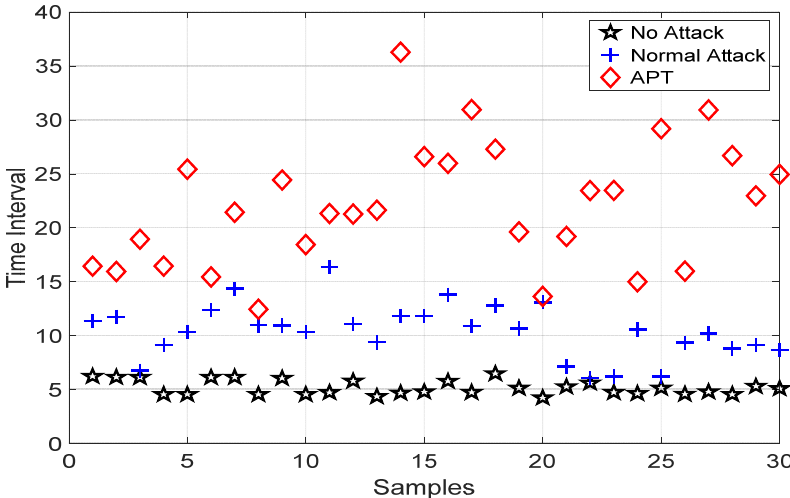
Figure 9. The average time interval difference.